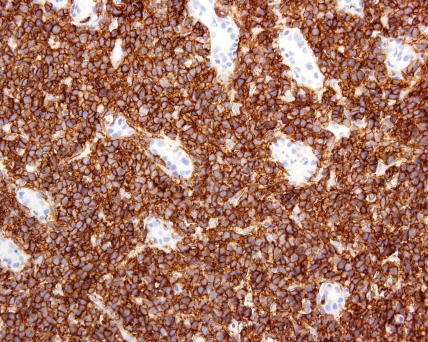
Strong CD20 PositivityDLBCL usually expresses various pan-B markers, e.g. CD20 and CD79a.